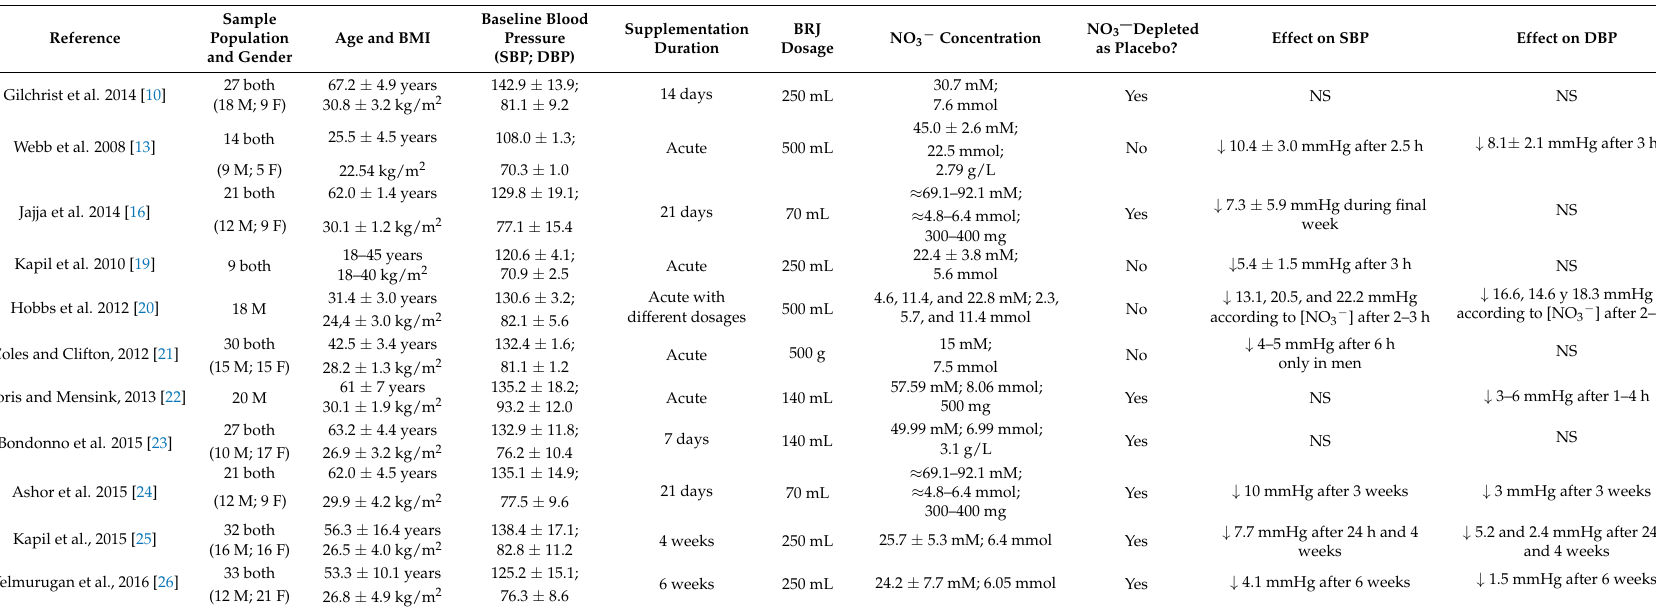
Table 1. Evidence for the effects of beetroot juice (BRJ) supplementation on blood pressure (BP). Table summarizing the main results of eleven studies included in the systematic